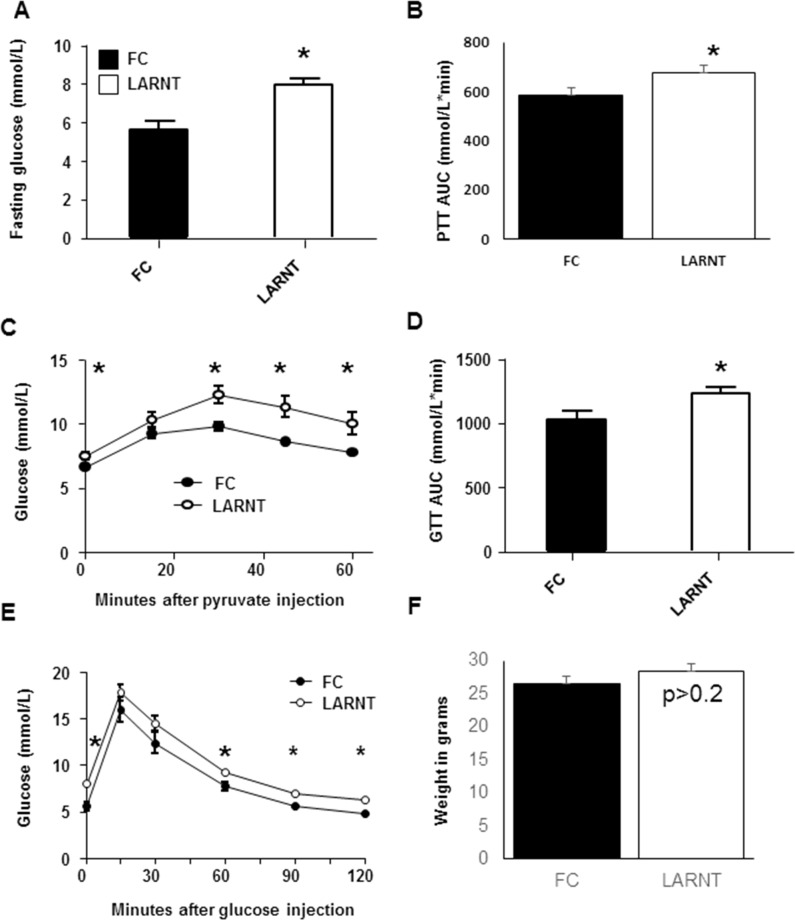
Hepatocyte specific ARNT knockout chow fed (LARNT) mice have impaired glucose metabolism.Results for floxed control (FC) mice are shown in black and LARNT mice in white (bars or circles) (A) Fasting blood glucose was higher in LARNT mice at 12 weeks. (B) Area under the curve (AUC) of pyruvate challenge tests (PCT) in FC and LARNT mice at 18weeks. (C) PCTs. (D) Glucose tolerance tests (GTT) AUC in FC and LARNT at 12 weeks. (E) GTT curves in FC and LARNT. (F) Body weight of FC and LARNT mice at 18–21 weeks. Mean±SEM, * = p<0.05. N = 5–13 per group.